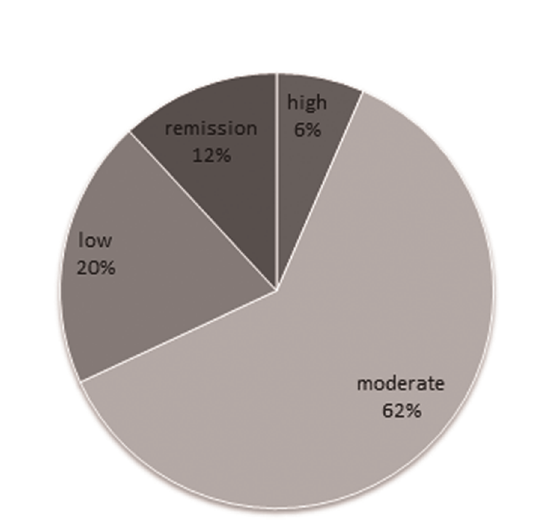
Figure 4. Error analysis of the best performing classifier. Out of 429 misclassified cases (using DAS28 derived dichotomous labels as gold standard), the majority are from the Moderate and Low disease activity categories.